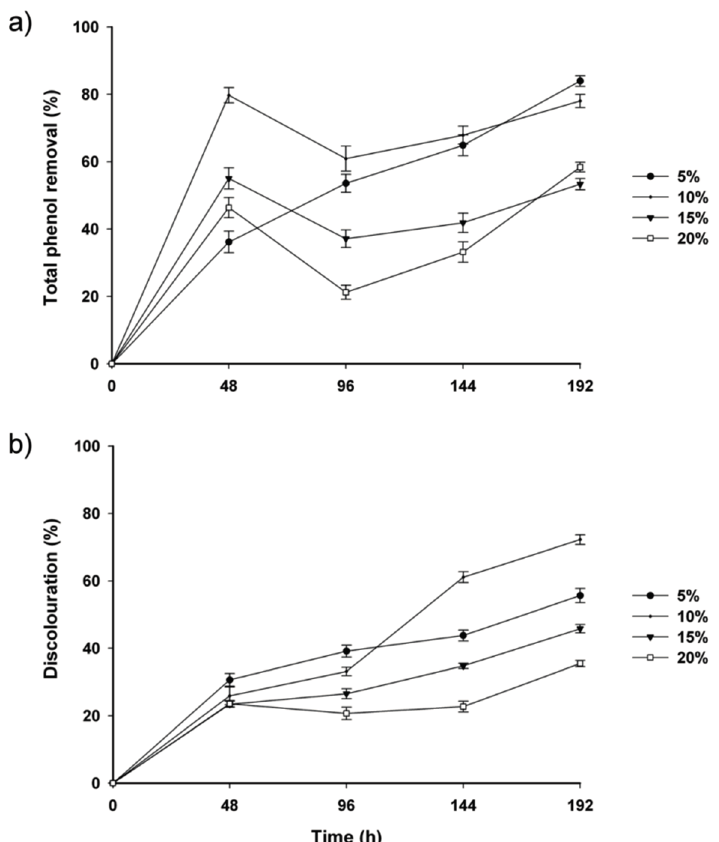
Figure 3. ( a ) Total phenol removal and ( b ) percentage of vinasse discoloration by T. hirsuta Bm-2 in different vinasse concentrations over 192 h of cultivation. Results were represented as means ± standard deviation of three parallel measurements ( n =